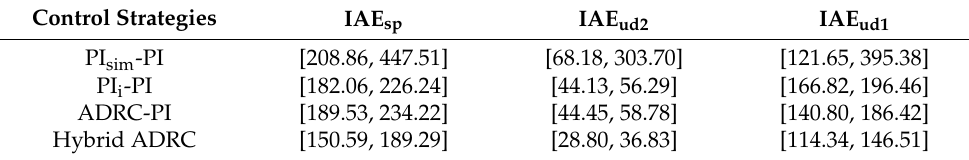
Table 6. Ranges of IAE sp , IAE ud2 and IAE ud1 of the perturbed SST system in the simulator. Control Strategies